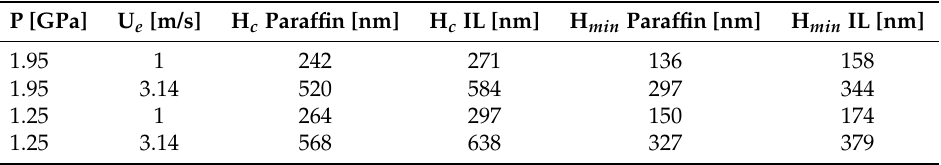
Table 6. Hamrock & Dowson central and minimum film thickness for friction